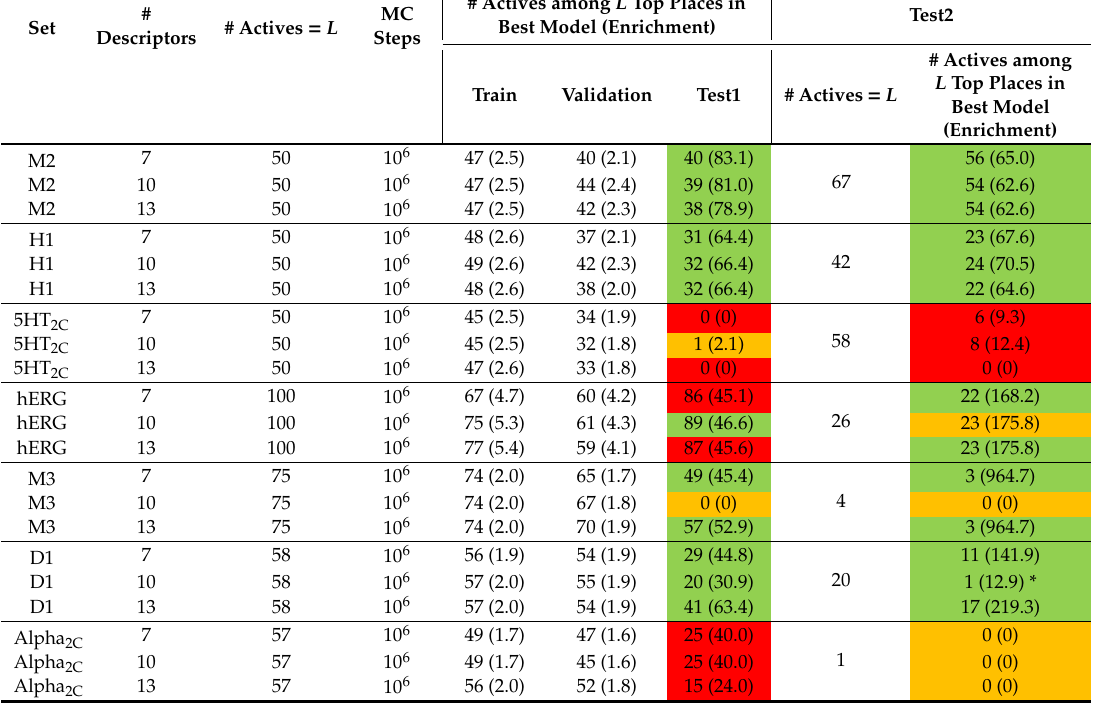
Table 2. Best (out of five repeats, based on the performances on the test sets) results obtained for the seven datasets using Enrichment Optimizer Algorithm (EOA). A compilation of all the results is provided in Tables S2–S8 (first sheet in each table) in the Supplementary Materials. Red, yellow and green coloring represent cases where EOA performances on test sets are poorer than, similar to or better than the corresponding Multiple Linear Regression (MLR) models presented in Table